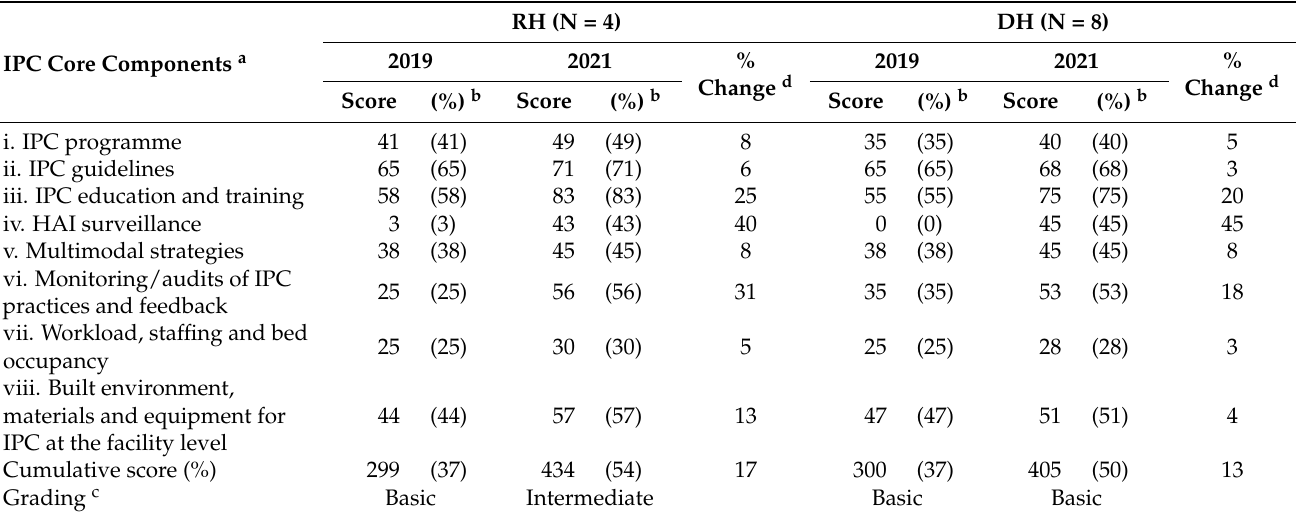
Table 3. Percentage change in median IPC scores at regional (N = 4) and district hospitals (N = 8) between 2019 (pre-COVID-19) and 2021 (COVID-19 era) in Sierra Leone.